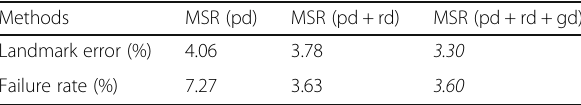
Table 2 Landmark errors and failure rates compared with different features of the MSR method on LFPW database Methods